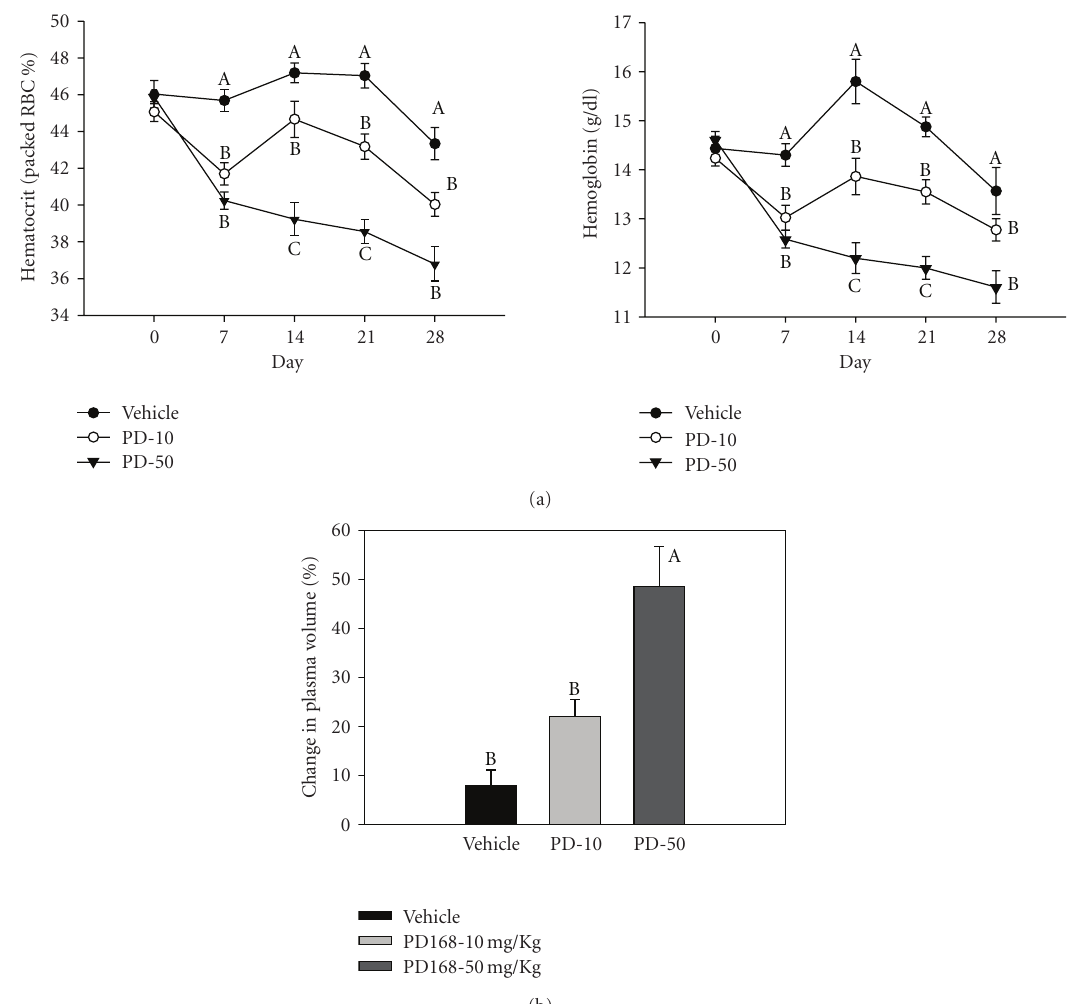
Figure 3: Hematocrit and hemoglobin levels in PD168-treated rats. (a) Percentage hematocrit (HCT) and hemoglobin levels and (b) percentage change in plasma volume, estimated indirectly by calculating percent change using baseline and final hemoglobin and hematocrit values in normal male SD rats chronically treated with vehicle (VEH), PD168 at the dose of 10 mg/kg · body weight (PD-10) or 50 mg/kg · body weight (PD-50), ( n = 10/treatment group). Means were compared using one-way ANOVA followed by the Holm-Sidak multiple comparisons test. Data are represented as means ± SEM. Points designated with “A” are significantly greater in value than those designated with “B” (by Holm-Sidak). p < 0 . 05 was considered